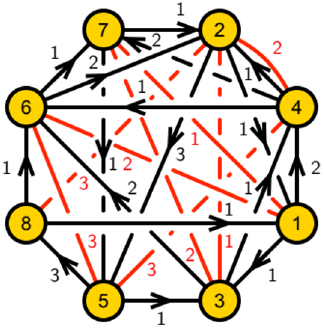
Figure 24 . Quiver for Model